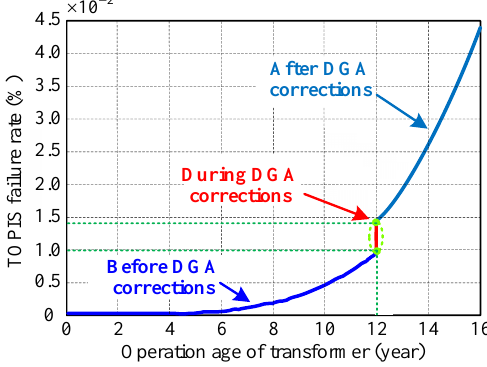
Figure 10. The curve of TOPIS failure rate after corrections. DGA: dissolved gas analysis.